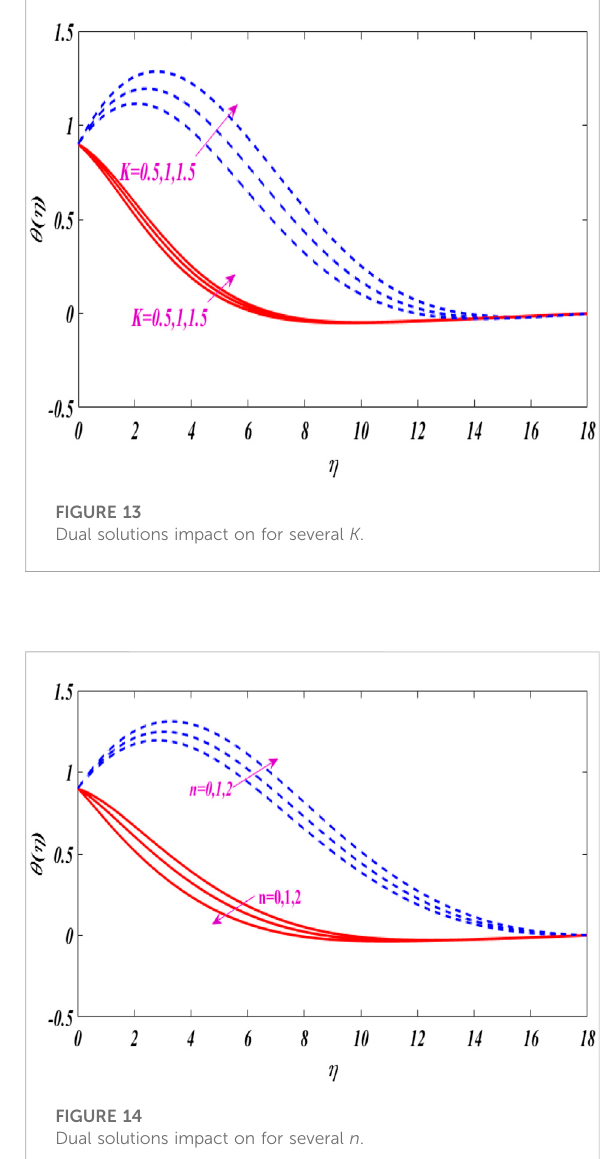
FIGURE 12 Dual solutions impact on for several M .